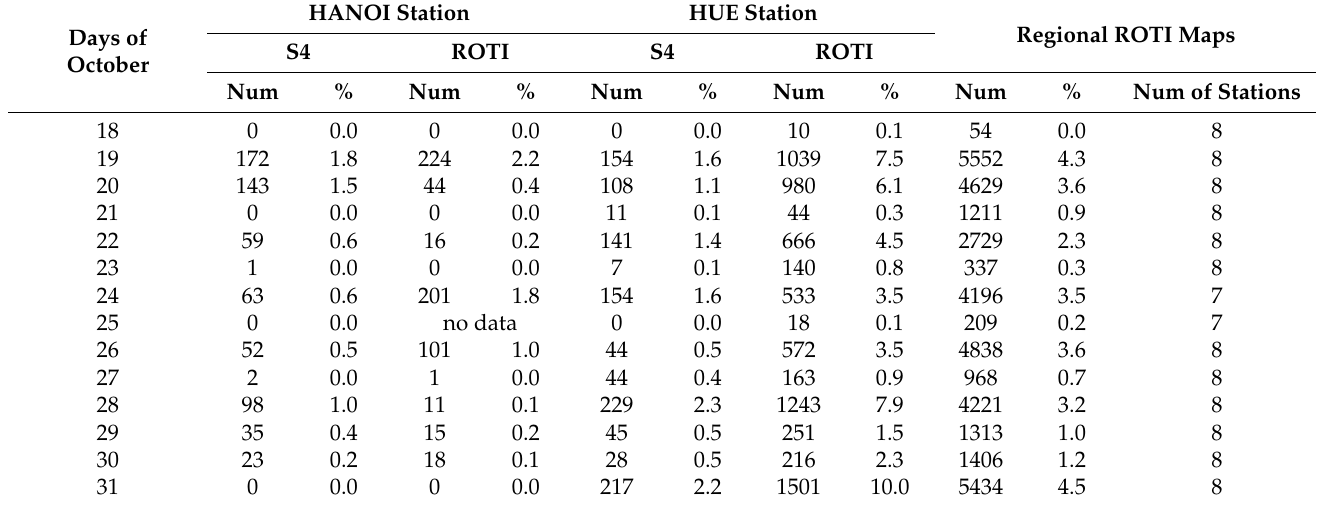
Table 3. Statistics for the S4 and ROTI indices and the ionospheric disturbances derived from the regional ROTI maps during the period of 18–31 October 2015.